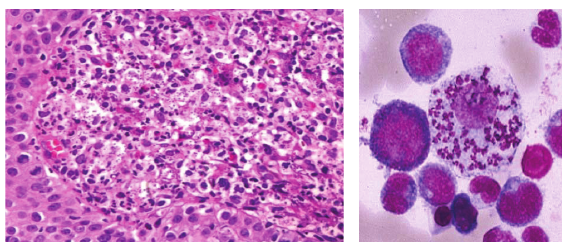
Figure 5: Giemsa staining shows numerous amastigotes with round nucleus.